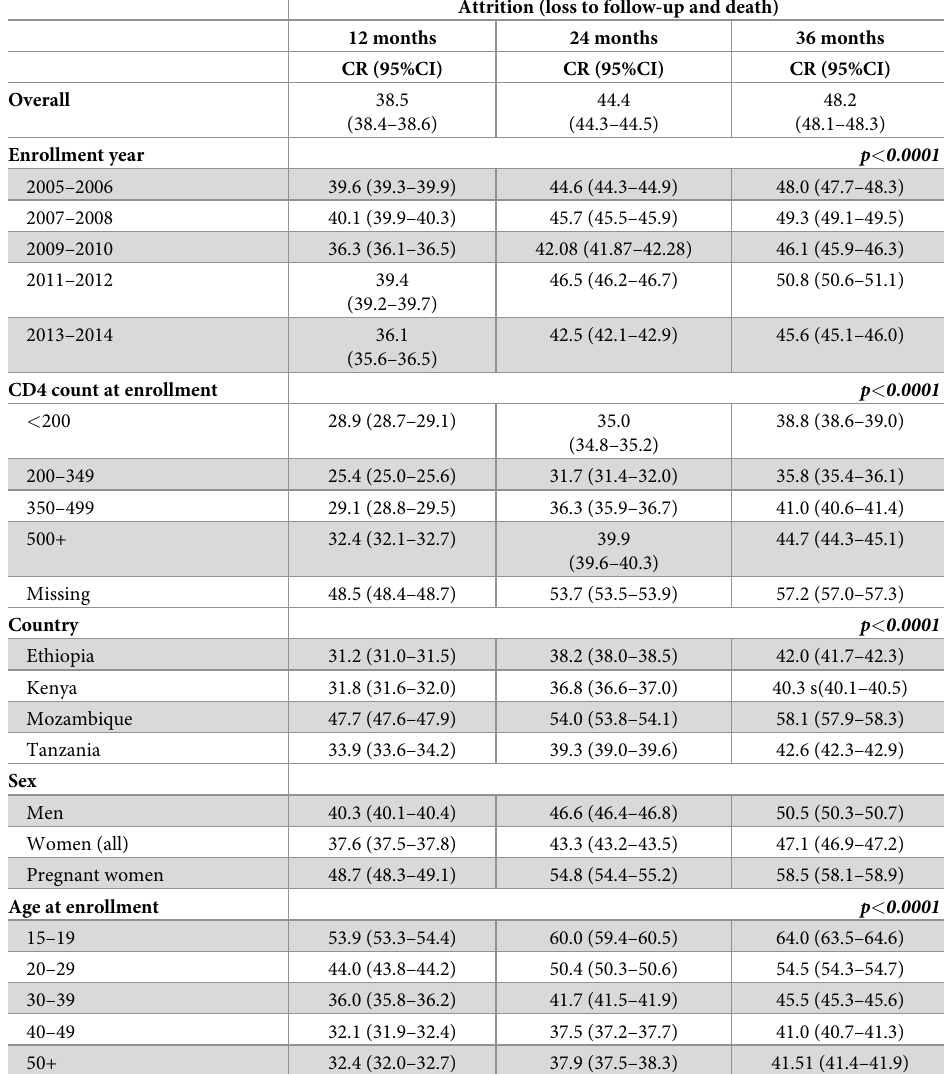
Table 4. Combined attrition for all adults ( > = 15 years) in care regardless of ART initiation enrolled at ICAP- supported health facilities in Ethiopia, Kenya, Mozambique and Tanzania 2005–2014 (N = 792,319). Attrition (loss to follow-up and